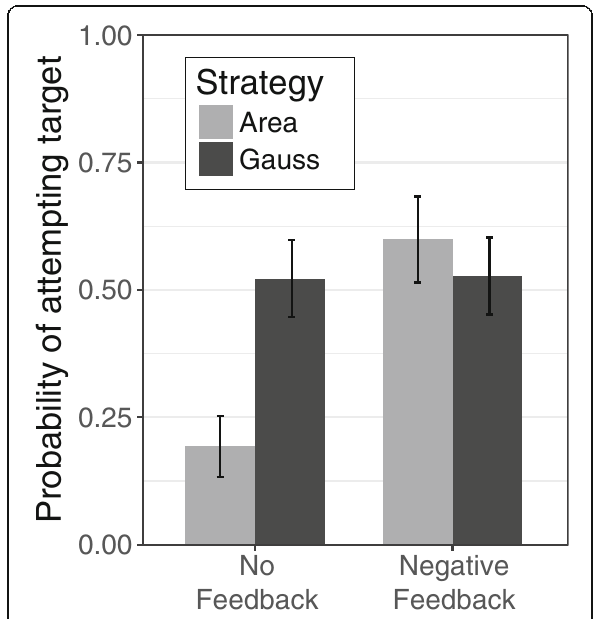
Fig. 6 The probability of adopting the area and Gauss strategies with no feedback and with negative feedback about the pretest (summation) strategy. Error bars display standard errors